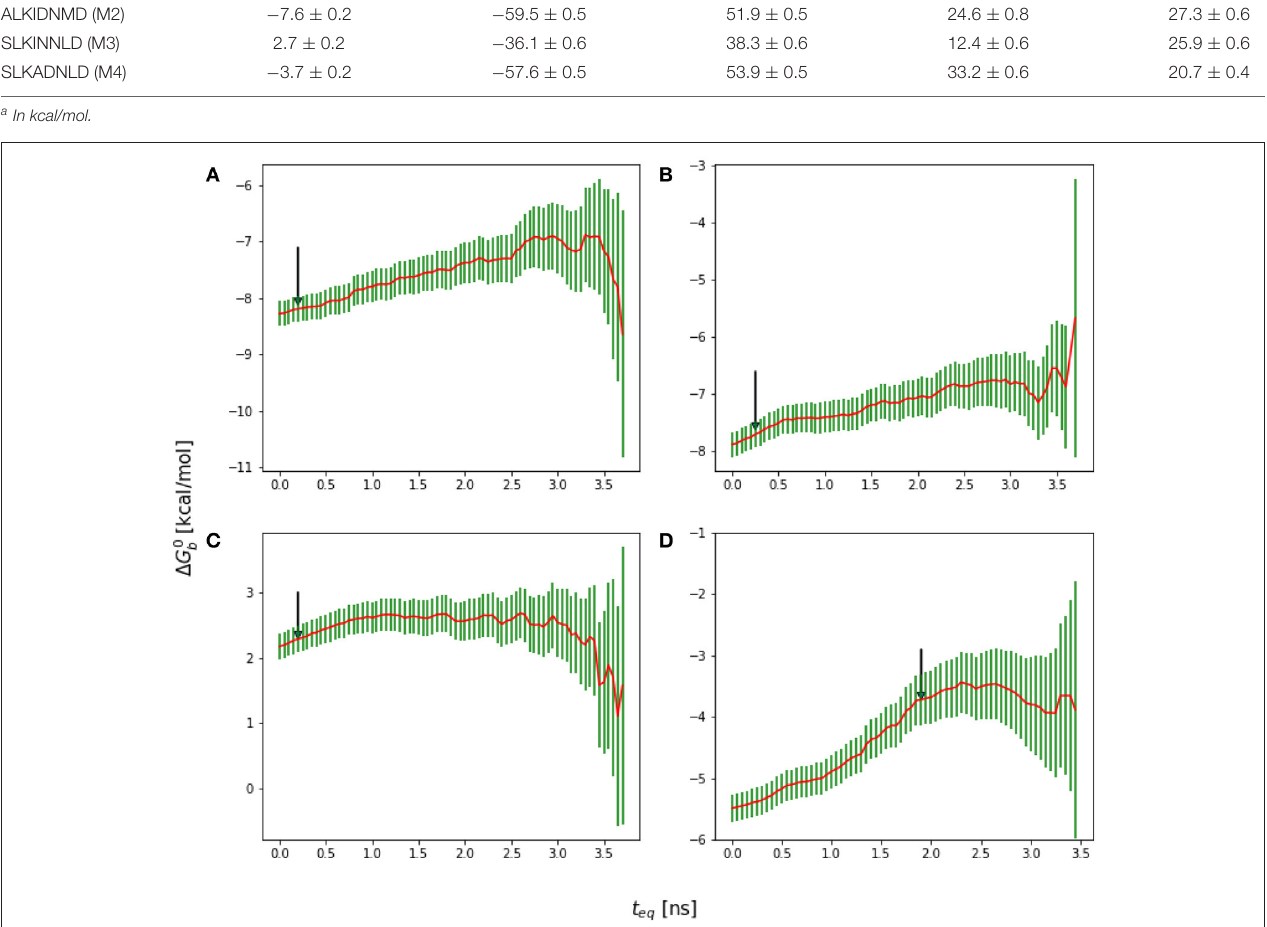
FIGURE 6 | Reverse cumulative binding free energy convergence plots for (A) Mutant 1 (S362A), (B) Mutant 2 (S362A/L368M), (C) Mutant 3 (D366N), and (D) Mutant4 (I365A). Arrows mark the estimated equilibration times based on auto correlation analysis: (A) 0.20 ns, (B) 0.25 ns, (C) 0.20 ns, and (D) 1.90 ns.